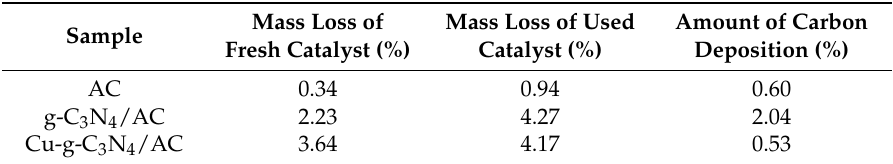
Table 4. Mass loss of the catalysts before and after